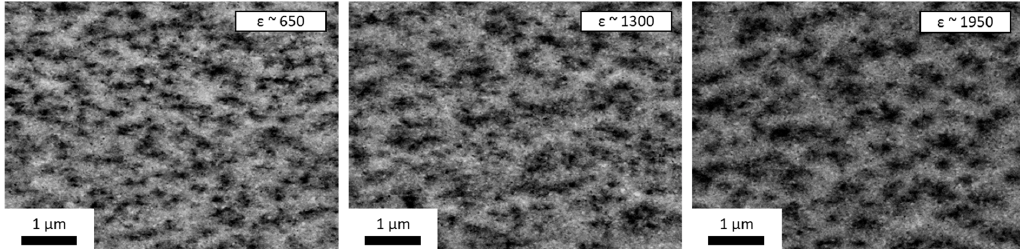
Figure 12. SEM—backscattered electron detection mode (BSE) micrograph of Cu 55 Co 45 , deformed with the large HPT tool at elevated temperatures. Micrographs were taken in tangential direction and for increasing radius (r = 5 mm, 10 mm, 15 mm) from left to right.